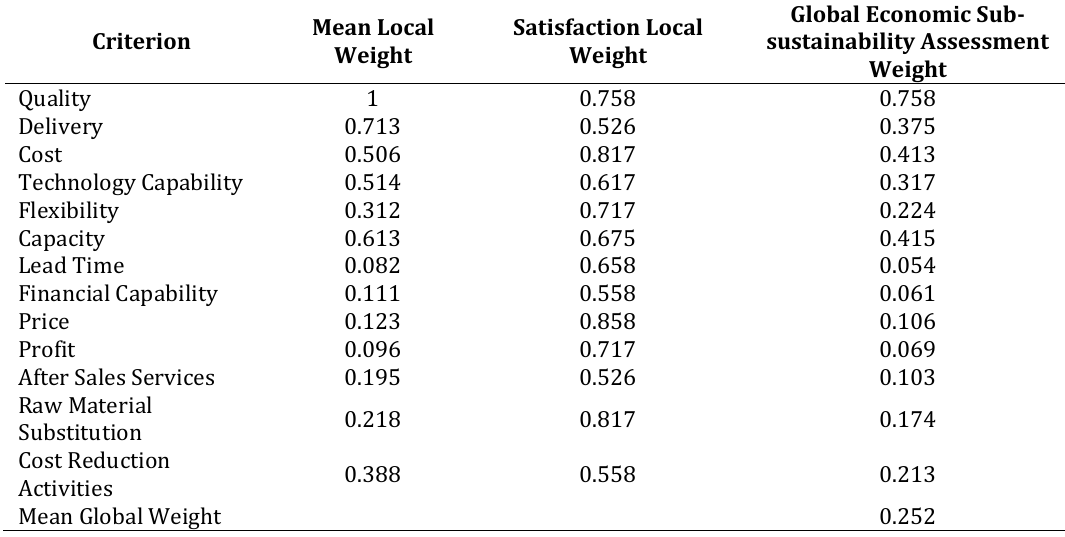
Table 1: Index weight and global weights of economic sub-sustainability assessment, macro- scale literature based assessment